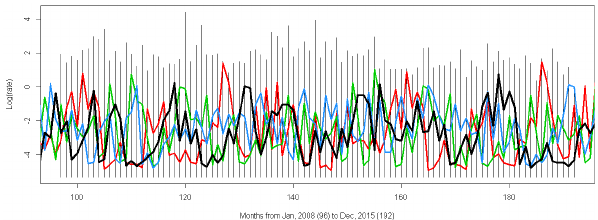
Figure 4: Needle plot of log e (rate) superimposed with fitted models: All (black), Z3:1 (red), Z3:2 (green), and Z3:3 (blue).